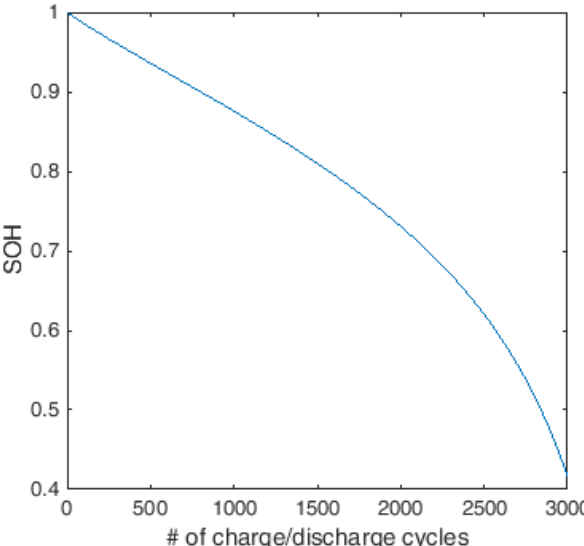
Figure 19. Estimate of the battery pack state of health (SOH) as a function of the number of cycles.